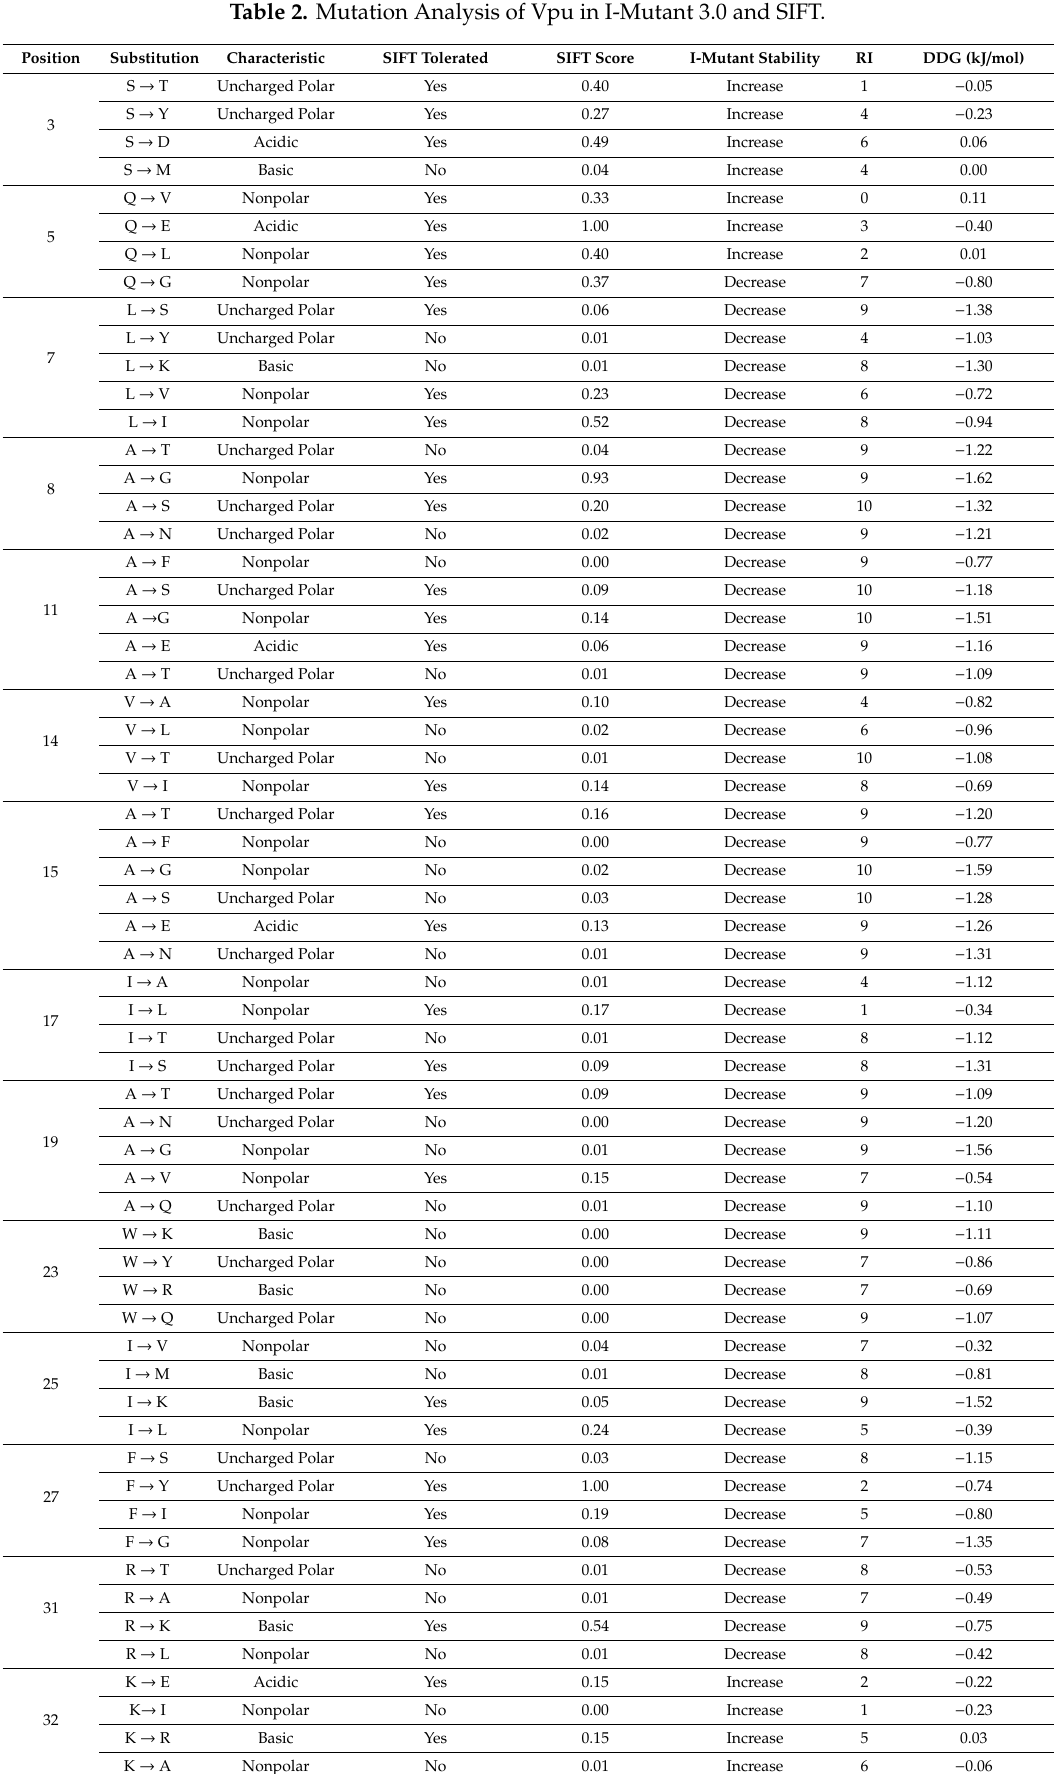
Table 2. Mutation Analysis of Vpu in I-Mutant 3.0 and